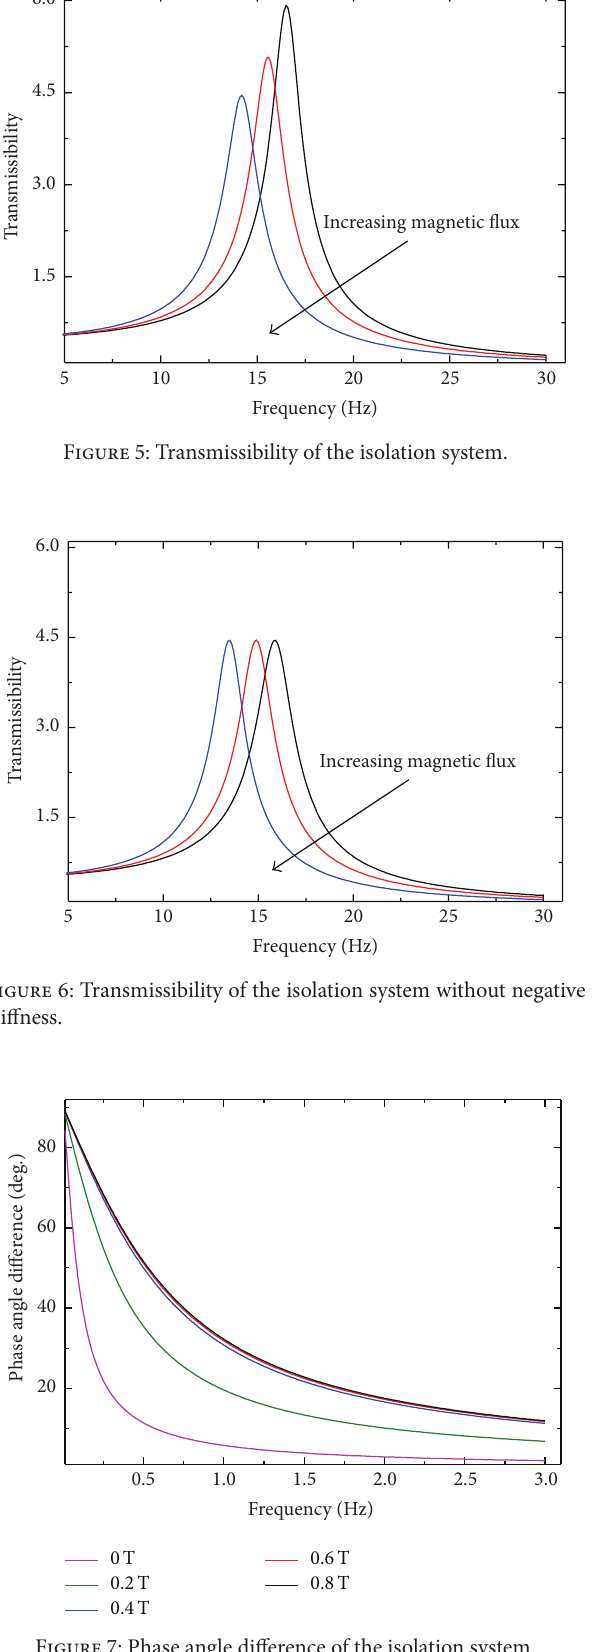
Figure 7: Phase angle difference of the isolation